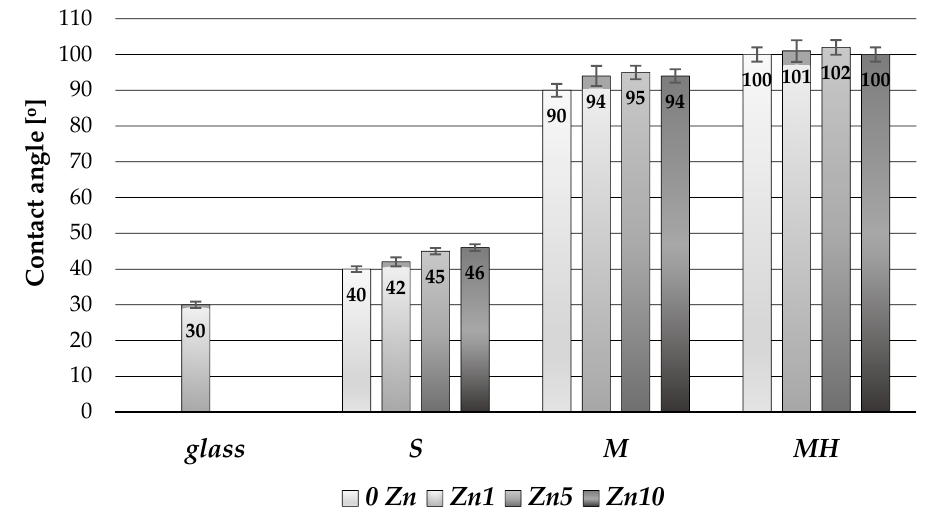
Figure 3. Wettability of coatings.